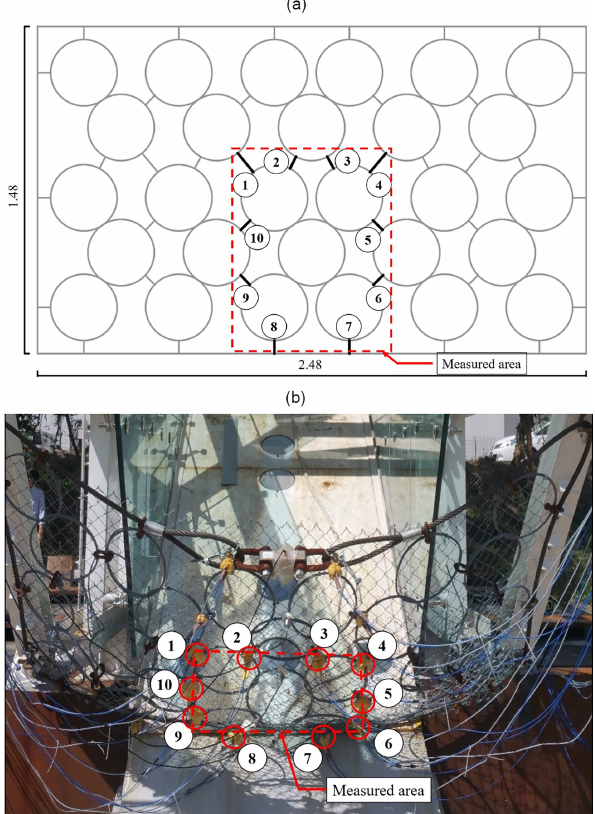
Figure 3. (a) Schematic diagram of a flexible barrier and (b) front view of the flexible barrier with numbered tension link transduc- ers between rings and the measured area in the physical model (unit: